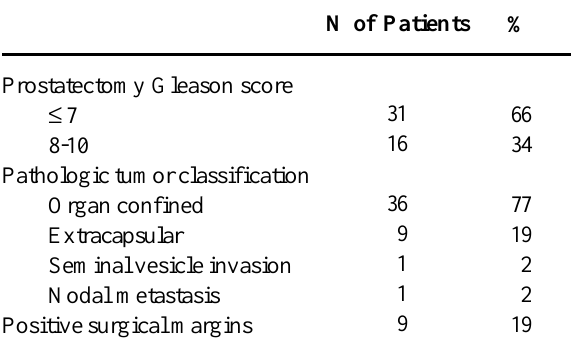
Table 3 – Pathologic characteristics of 47 patients undergoing radical prostatectomy and treated with enoxaparin in the immediate postoperative